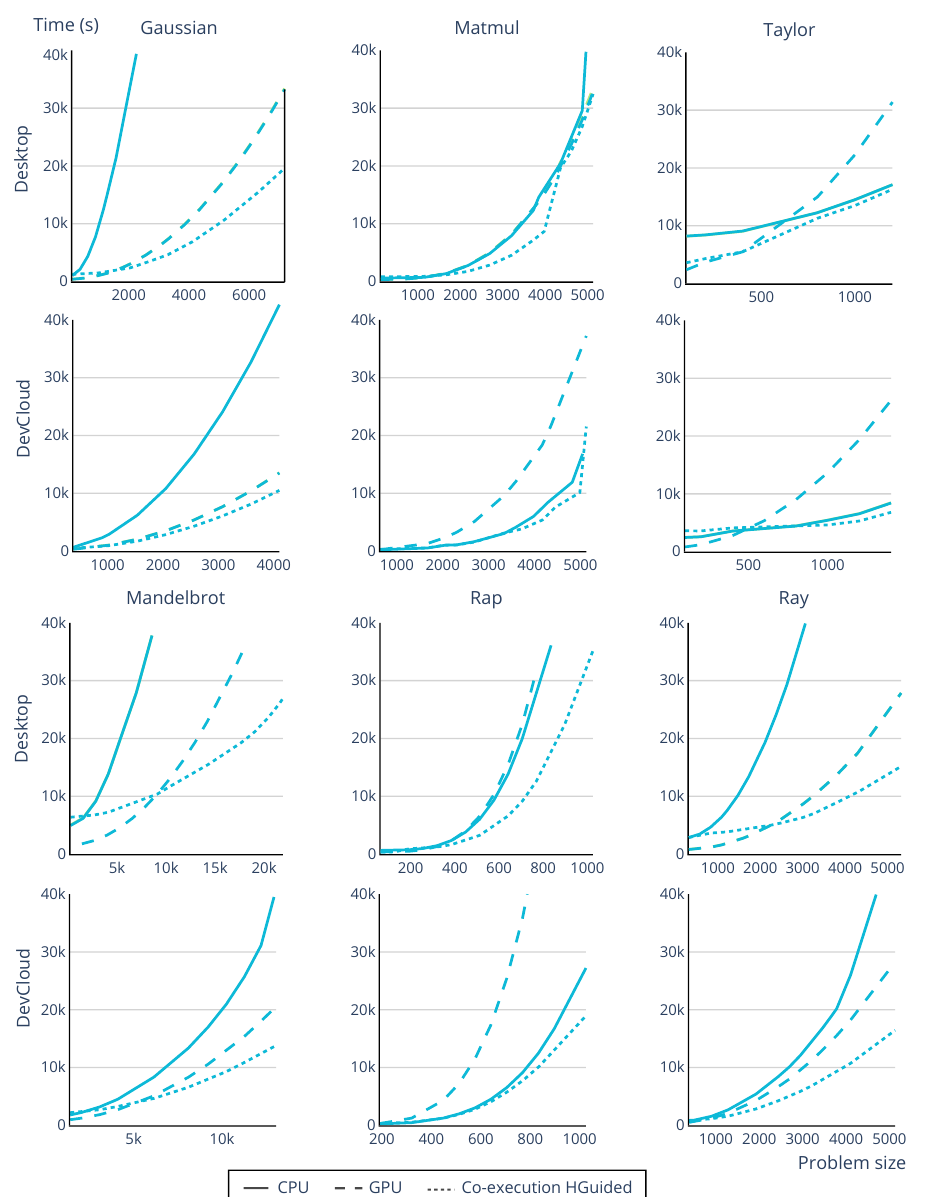
Figure 8. Scalability for CPU, GPU and CPU-GPU coexecution using the Coexecutor runtime with its HGuided scheduling policy and USM memory model for Desktop and DevCloud